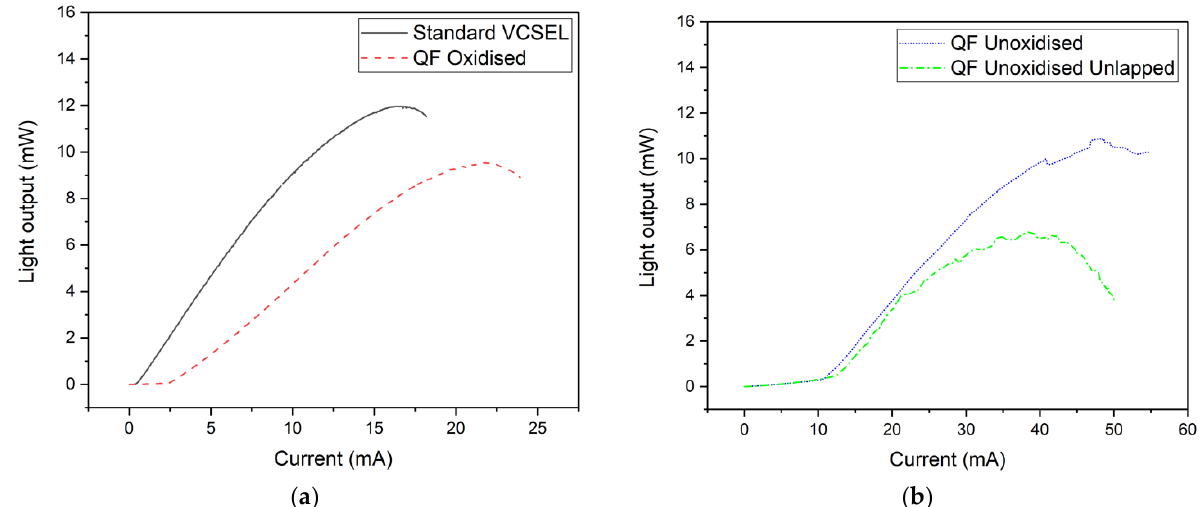
Figure 5. Light – current characteristics for ( a ) 6 𝜇 m aperture standard and QF VCSEL; ( b ) 30 𝜇 m mesa lapped and un- Figure 5. Light–current characteristics for ( a ) 6 µ m aperture standard and QF VCSEL; ( b ) 30 µ m mesa lapped and unlapped lapped unoxidised QF VCSEL. unoxidised QF VCSEL.